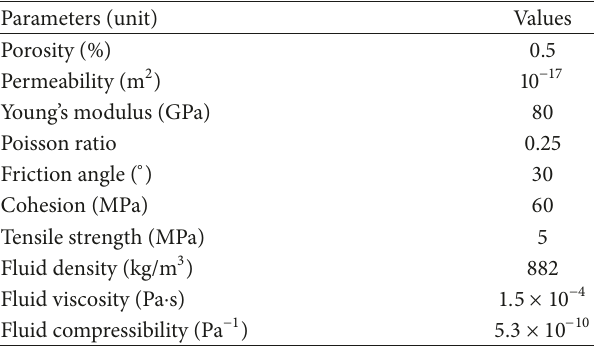
Table 1: Rock mechanical and hydraulic parameters in the numeri- cal